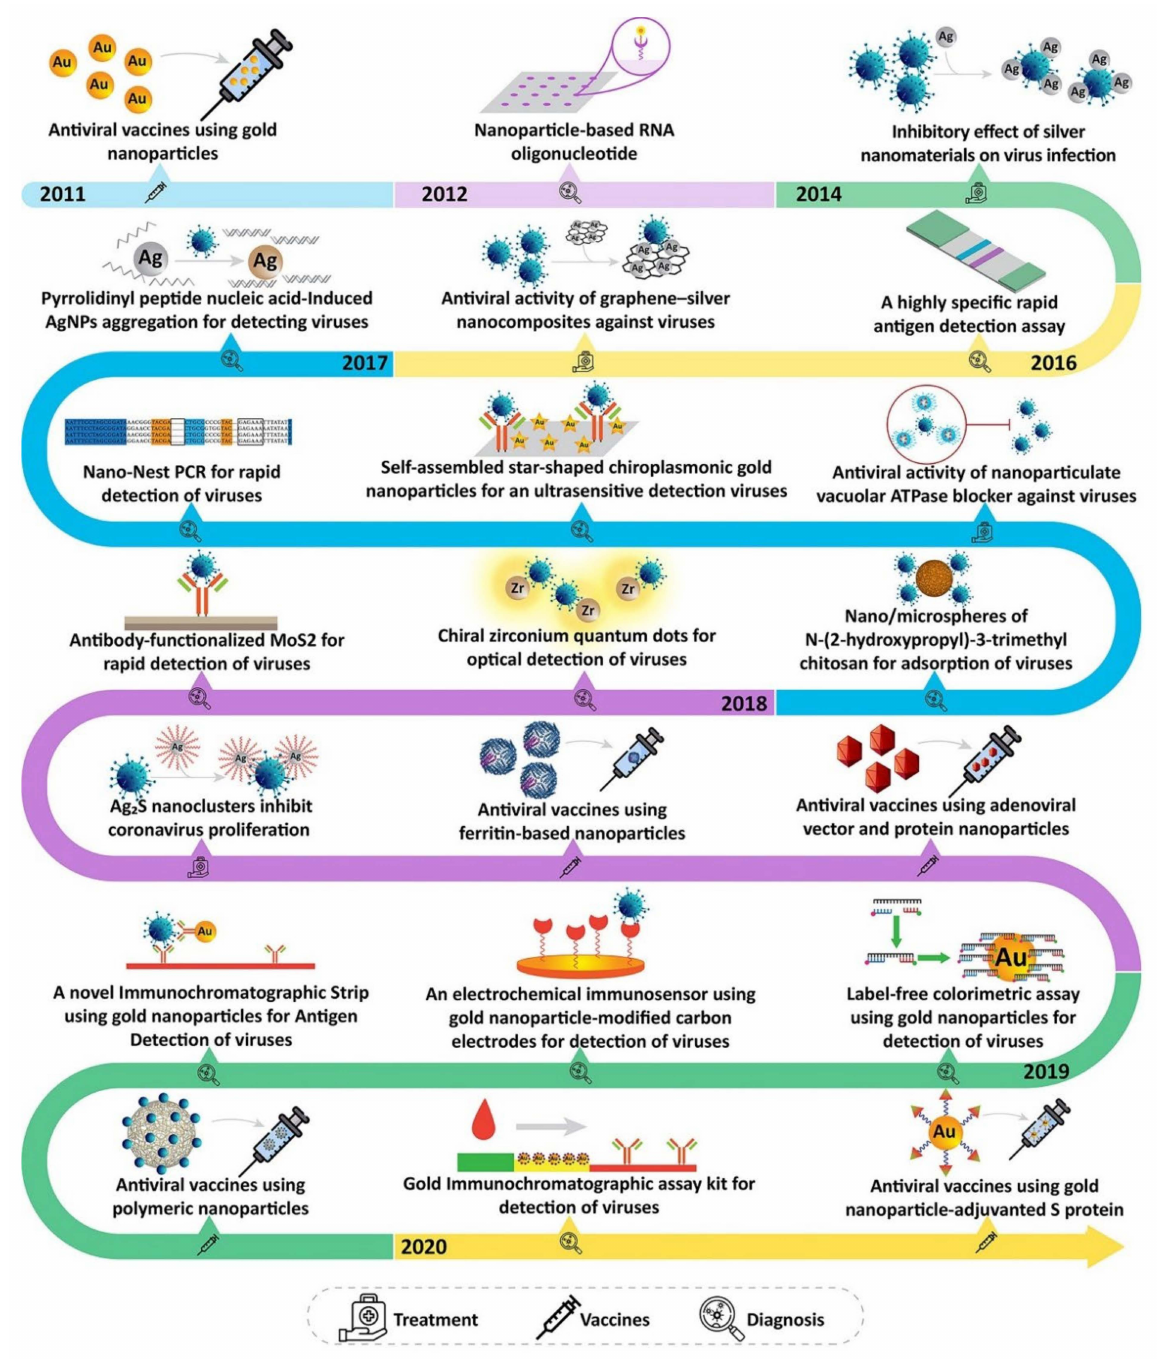
Figure 2. The effective role of nanoparticles in inhibiting viruses as nano-vaccine components, biosens- ing, and nanomedicine. Reproduced with permission from [33]. Copyright American Chemical Society,